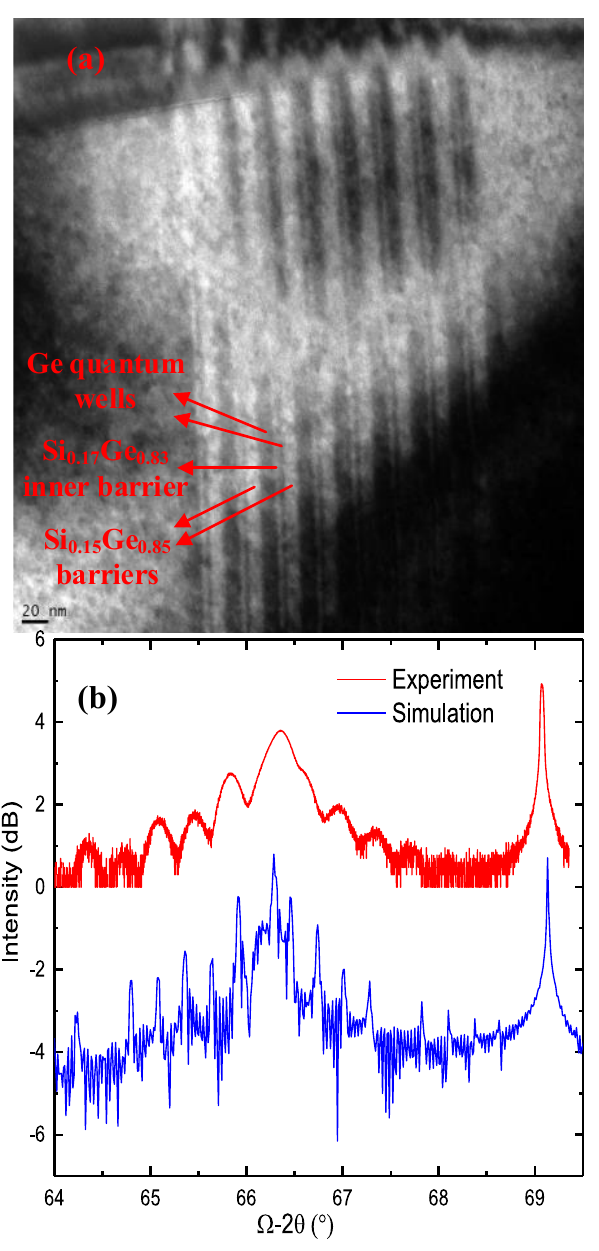
Figure 2: (a) TEM image of the Ge/SiGe CQWs. (b) X-ray diffraction scan along [001] direction.